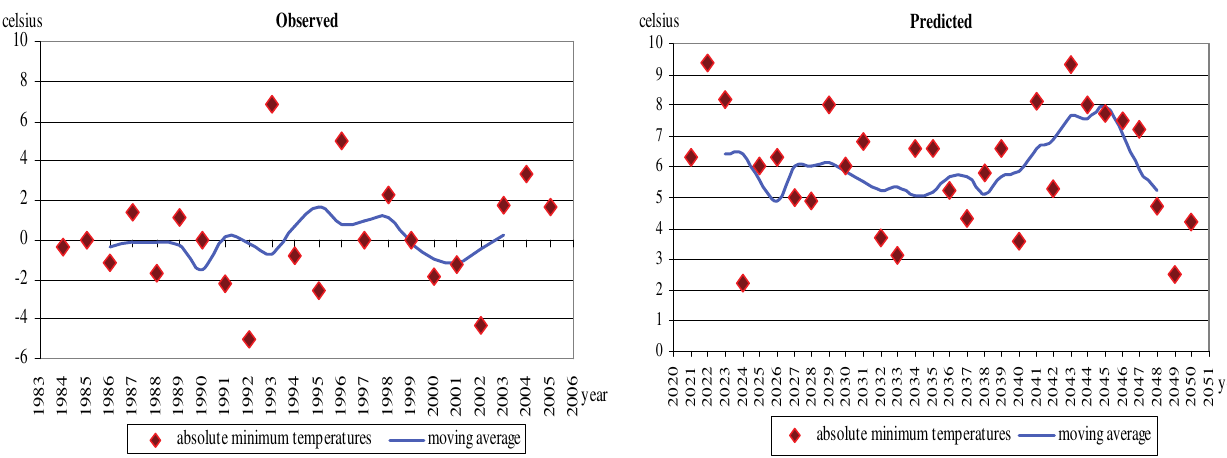
Figure 2: The observed (Left) and estimated (Right) absolute minimum temperatures at Újfehértó, estimation have been made by means of the RegCM 3.1 model for the period 10 days before bloom plus blooming time